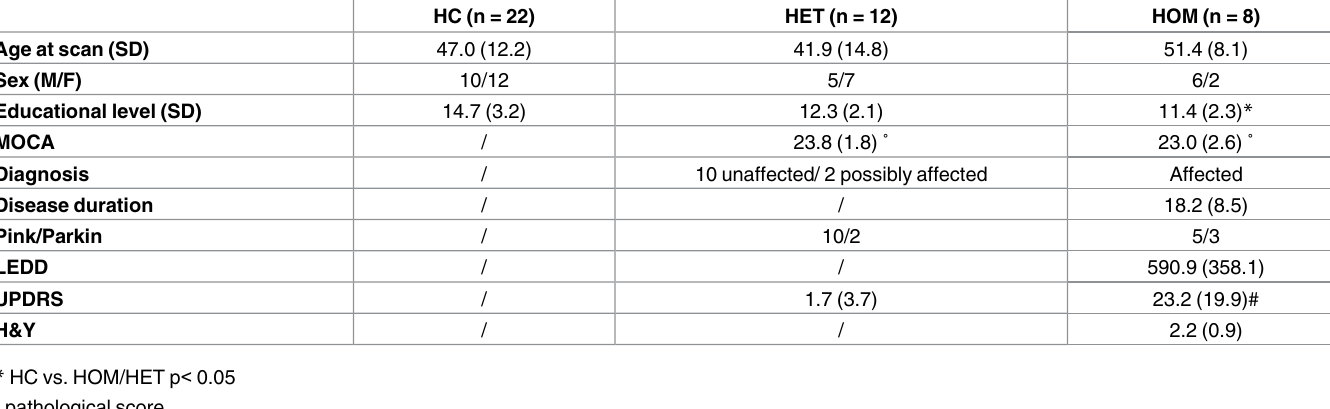
Table 1. Principal demographic and clinical characteristics of studied subjects. Abbreviations: HET = heterozygous; HOM = homozygous; HC = healthy controls; SD = standard deviation; LEDD = Levodopaequivalentdaily dose; UPDRS = Unified Parkinson’sDisease Rating Scale; MOCA = Montreal CognitiveAssessment; H&Y = Hoehn and Yahr